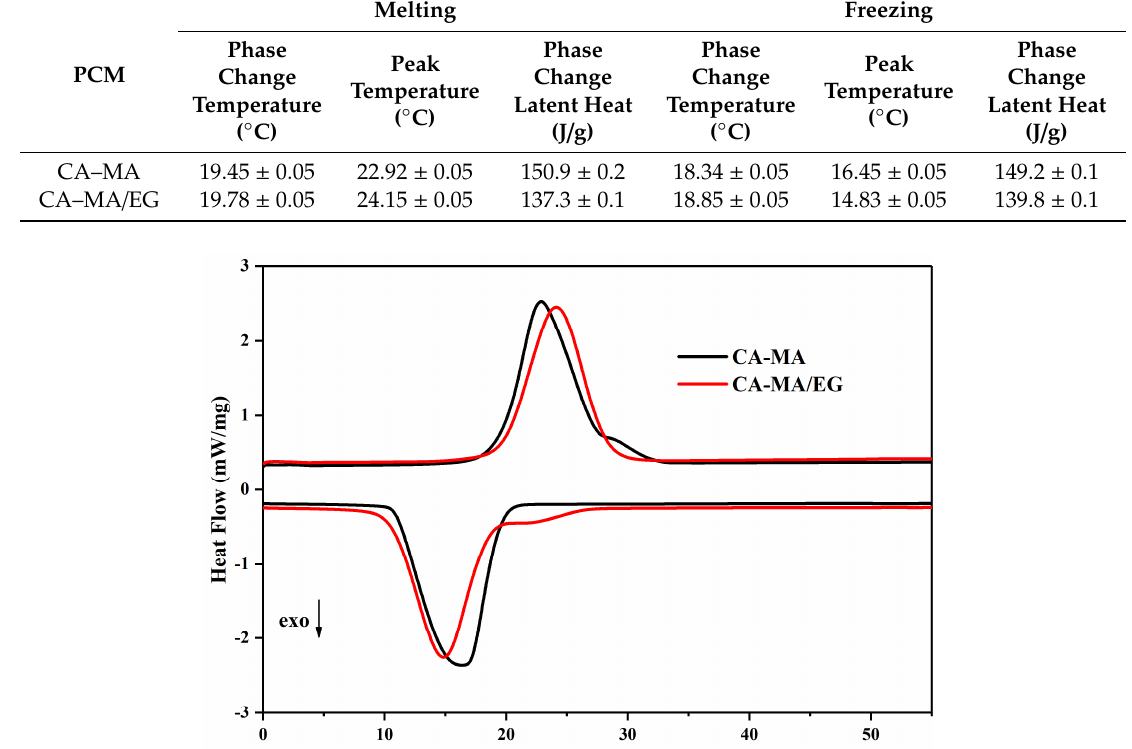
Figure 2. Di ff erential scanning calorimetry (DSC) graphs of CA–MA and CA–MA / Figure 2. Differential scanning calorimetry (DSC) graphs of CA–MA and CA–MA/EG. Table 2. Heat performances of CA–MA and CA–MA/EG.